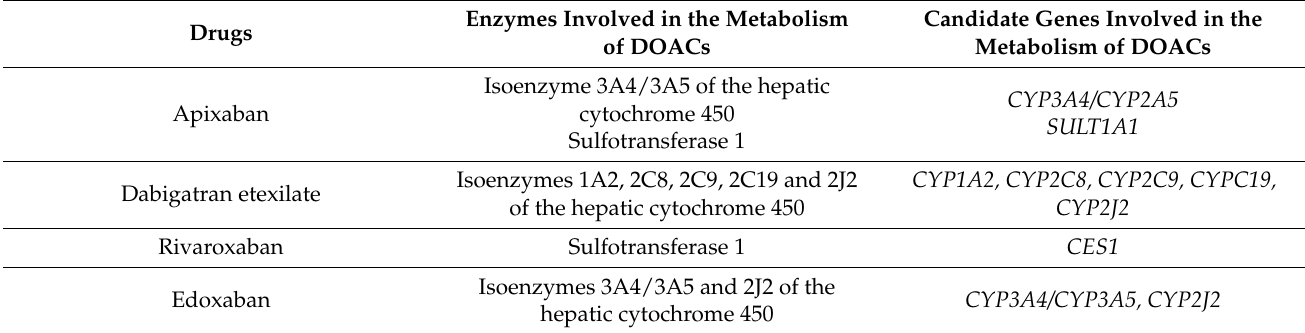
Table 2. The candidate genes predisposing to changes in the DOACs’ metabolism.